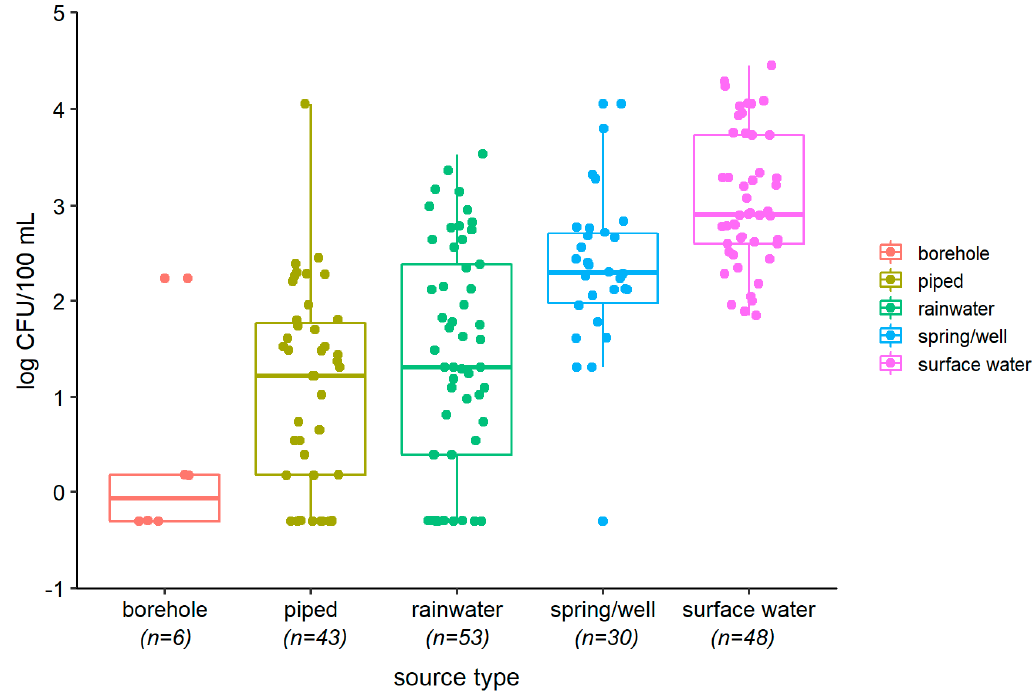
Figure 1. Boxplots showing levels (colony-forming units (CFU) / 100 mL) of E. coli by source type (superimposed dots show bacteria counts for individual samples).